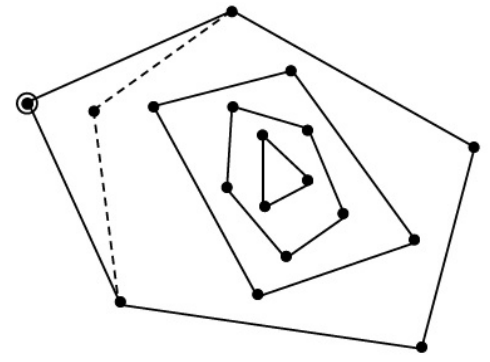
Figure 9: A new point appears.